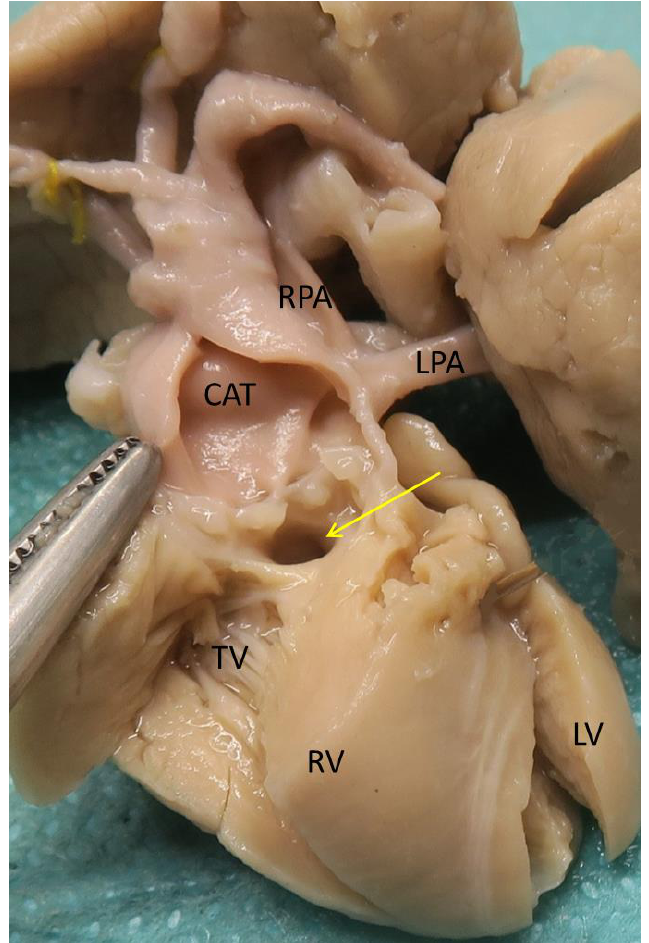
Figure 3. Heart specimen with common arterial trunk type 1 and hypoplastic right ventricle (Table 3, Case 33). The truncal valve is quadricuspid. Yellow arrow, outlet ventricular septal defect; CAT, common arterial trunk; LPA, left pulmonary artery; LV, left ventricle; RPA, right pulmonary artery; RV, right ventricle; TV, tricuspid valve. 4.2. Mitral Atresia and Left Ventricle Hypoplasia Mitral atresia or LV hypoplasia was found in 12/39 cases (31%). Mitral atresia was observed in six cases and LV hypoplasia in six. One case was associated with Di George syndrome (Case 17). None of the cases had situs or looping anomalies. Systemic venous returns were normal except for four cases of persistent left superior caval vein, draining in the coronary sinus in three (Cases 18,36,37), and the site of drainage being not specified in one (Case 16). Two cases of AVPR were found: one had total APVR to the coronary sinus (Case 37) and the other was partial (right upper pulmonary vein in the right supe- rior caval vein, Case 13). An intact ventricular septum was found in seven cases, and a subarterial conus was described in eight cases (Figure 4). There was an outlet VSD in